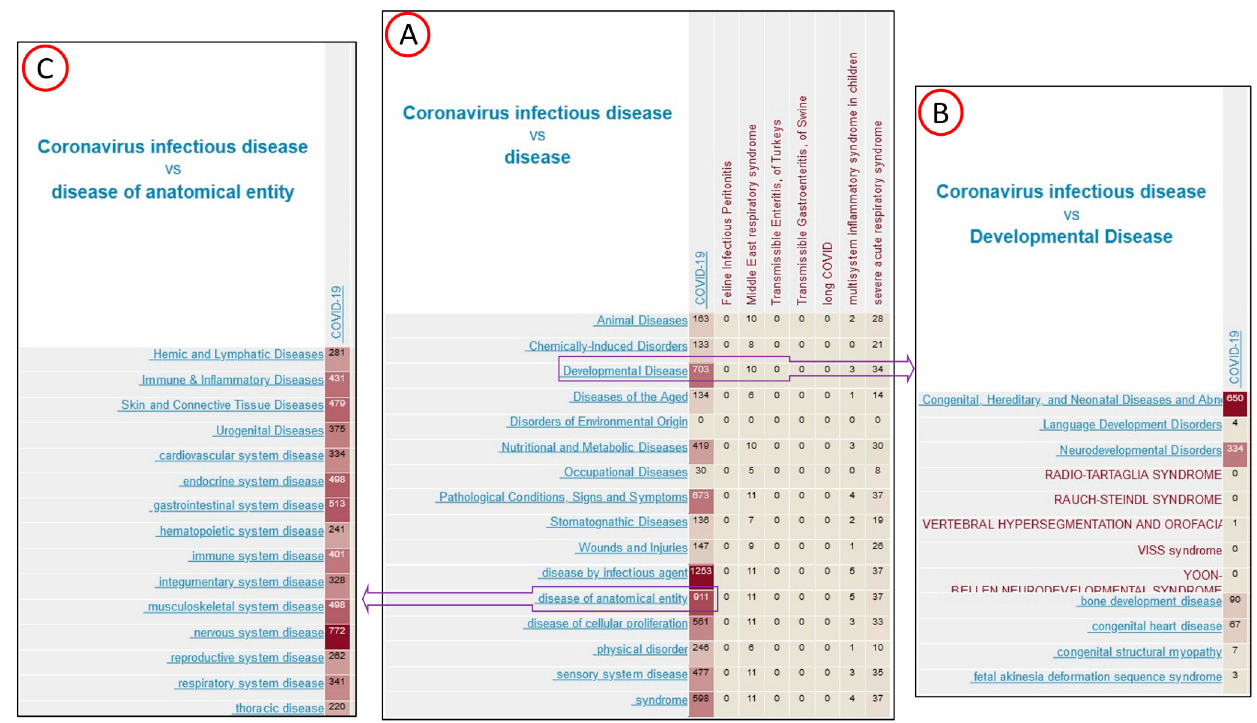
Figure 3. The disease term Comparison Heat Map visualized in the Gene Annotator tool. ( A ). COVID disease genes were visualized by their association with high level disease terms. ( B ). COVID genes associated with developmental disease were expanded to show their association with more granular terms under the branch. ( C ). COVID genes associated with disease of anatomical entity were expanded to show their association with more granular terms under the branch.